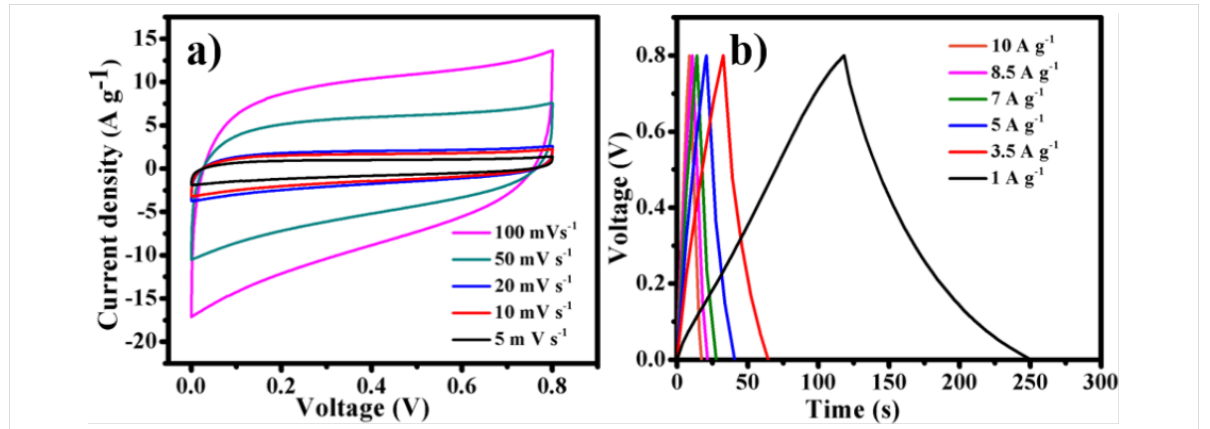
Figure 11: (a) CV curves for the fabricated SSHSC at different scan rates and (b ) GCD curves of SSHSC at different current densities.